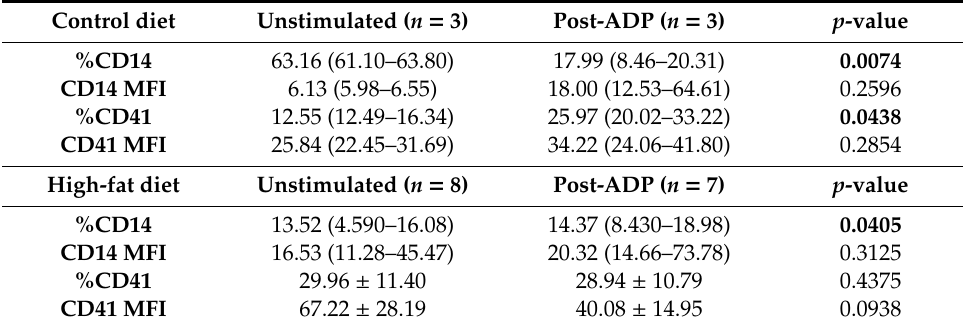
Table 3. Platelet monocyte aggregate (PMA) formation following stimulation with 20 µ M of adenosine